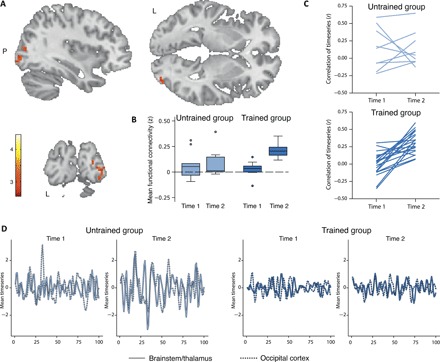
Learning to read strengthens cortico-subcortical functional connectivity.(A) Voxel-wise functional connectivity map derived from seeding in the significant degree centrality cluster. The image is thresholded at z = 2.58 (P < 0.005, corrected for cluster size). The color bar indicates the range of z scores. Becoming literate goes along with increased coupling of BOLD signal time courses between mesencephalic/diencephalic visual nuclei and a single cluster spanning the areas V1, V2, V3, and V4 of the right occipital cortex (MNI coordinates: +24, −81, +15; +24, −93, +12; +33, −90, +3). (B) The group (reading-trained individuals versus untrained illiterates) by time (before versus after intervention) interaction becomes evident from the box plot, indicating that the functional connectivity is strongly and specifically enhanced in the group that underwent reading instruction. (C) Line graphs depicting the coefficients of the correlations between the hemodynamic time series separately for each individual subject, each group, and each time. (D) Mean time series of the BOLD signal for each group and each time.